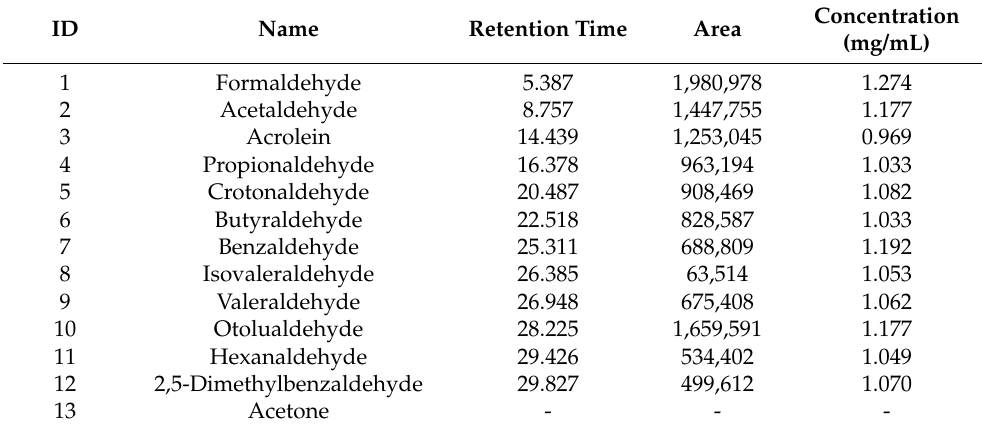
Table 8. Peak table of the reference standard.